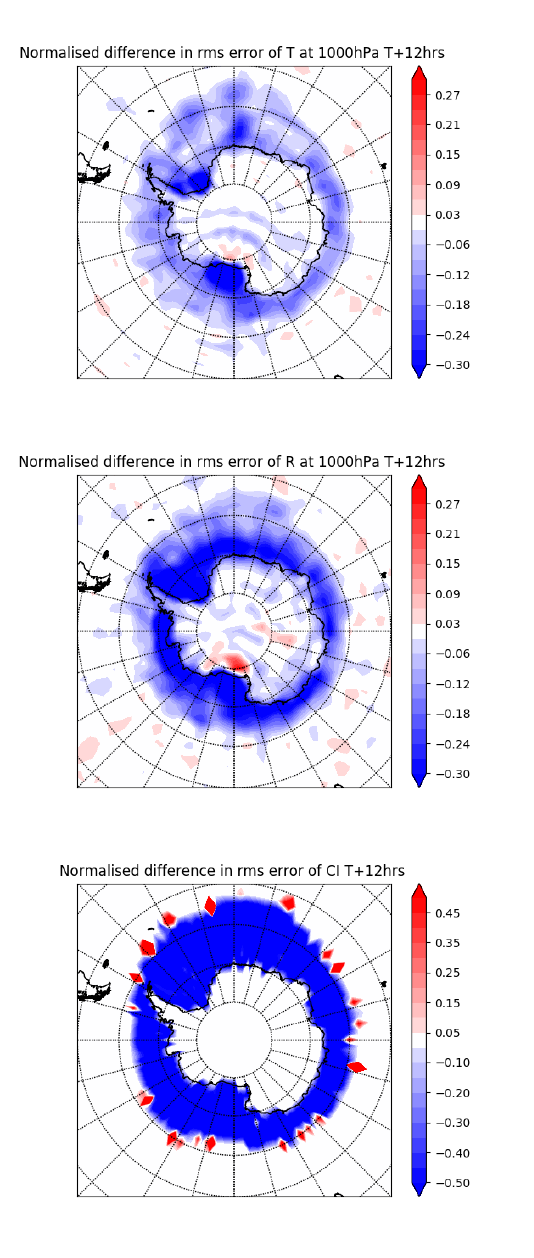
Figure 8. Spatial maps centred on the Antarctic of the normalised difference in RMSE between WCDA and the control for 1000 hPa temperature ( top ), 1000 hPa humidity ( middle ) and sea ice concentration ( bottom ) forecasts at 12 h ( left ) and 24 h ( right ) lead times (120 h lead time for sea ice concentration), for the period 9 June 2017 to 21 May